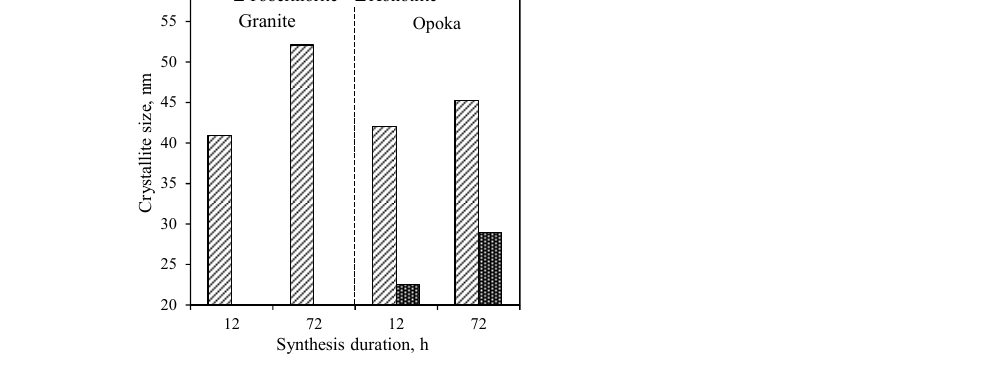
Figure 3. Dependence of the 1.13 nm tobermorite and xonotlite crystallite size on the duration of synthesis from lime–GSW and lime–calcined opoka mixtures.